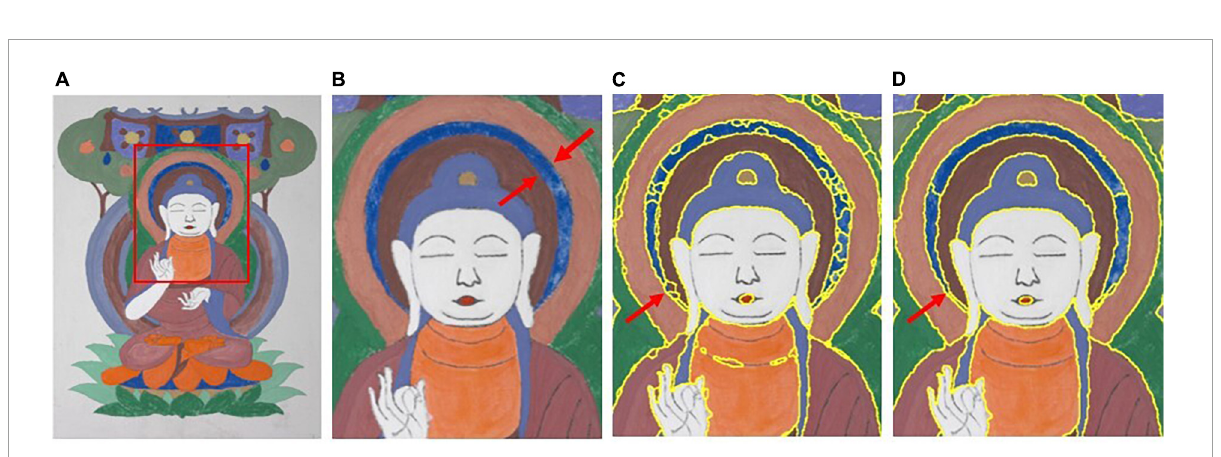
FIGURE5 Comparison of the segmenting results between the proposed method and the method proposed by Kovesi (2013). (A) Test image. (B) ROI of test image. (C) Kovesi. (D)